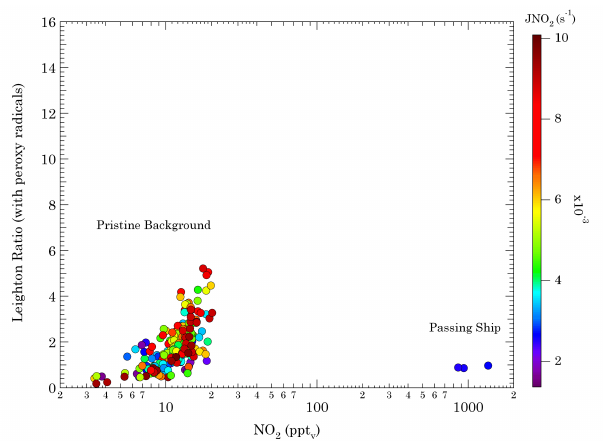
Fig. 7. Leighton ratio calculated using peroxy radical measure- ments from the PERCA instrument plotted as a function of NO 2 mixing ratios. The colour bar indicates the J NO tal uncertainties were calculated for the Leighton ratio, for several NO 2 mixing ratios and are estimated to be 158%, 147% and 131% for NO 2 mixing ratios of 3, 5 and 10pptv